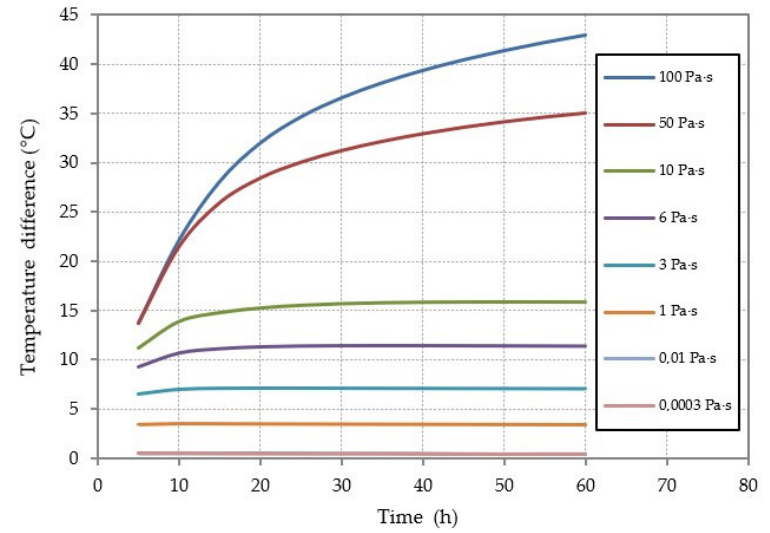
Figure 3. Liquid vertical temperature differences over time for various dynamic viscosities.